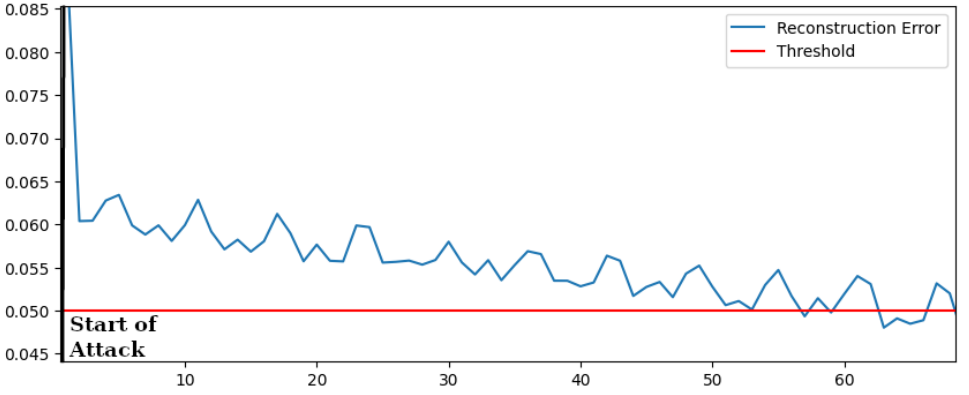
Figure 8. Reconstruction Error—Oscillating